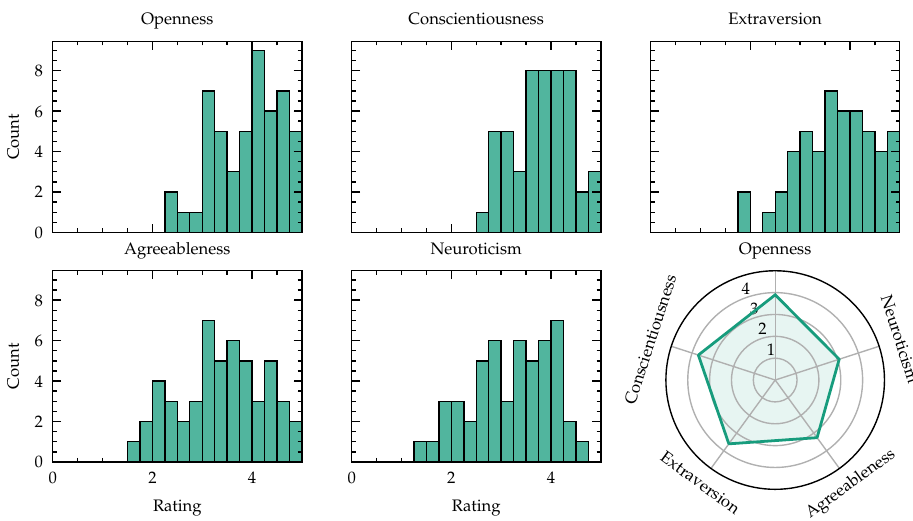
Figure 13. Big-Five personality traits: openness, conscientiousness, extraversion, agreeableness, neuroticism visualized as histogram and radar plot of mean values.